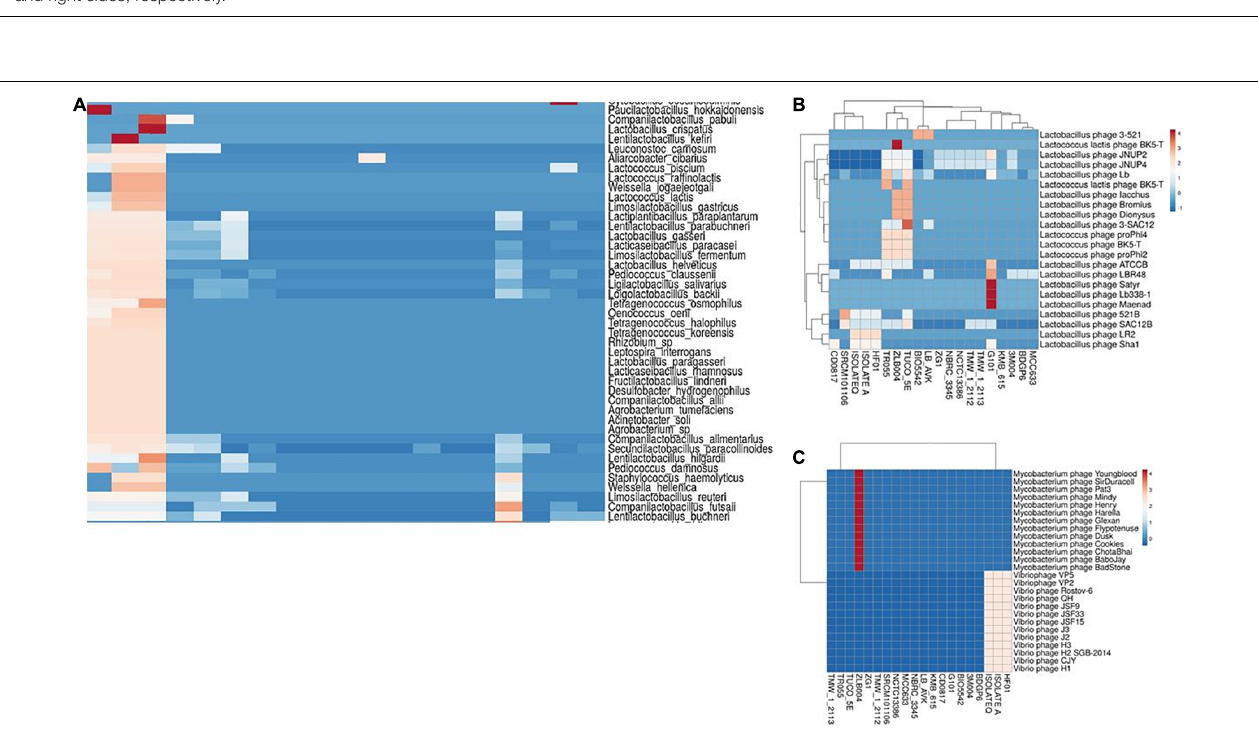
FIGURE 6 | Graphical representation of spacer pattern in subtypes II-A (A) and I-E (B) CRISPR-Cas systems. Gray squares containing an “X” represent no spacers. Each color combination represented a unique spacer sequence based on the nucleotide sequences. The newly and earliest acquired spacers are shown on the left and right sides, respectively.